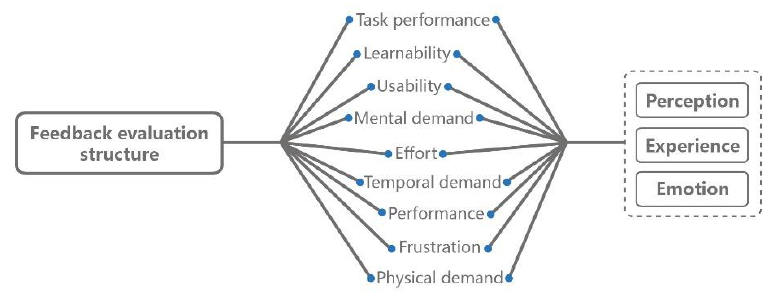
Figure 2. The evaluation framework associated with the customization experience in this study.